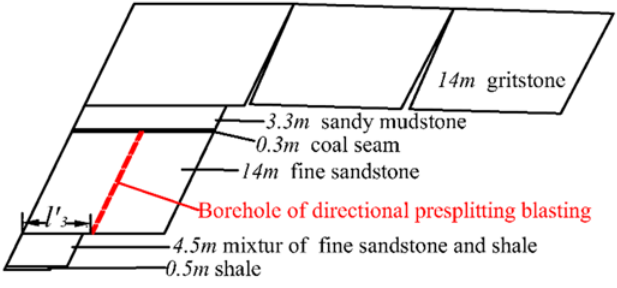
Figure 4. The blasting model of the cantilever.